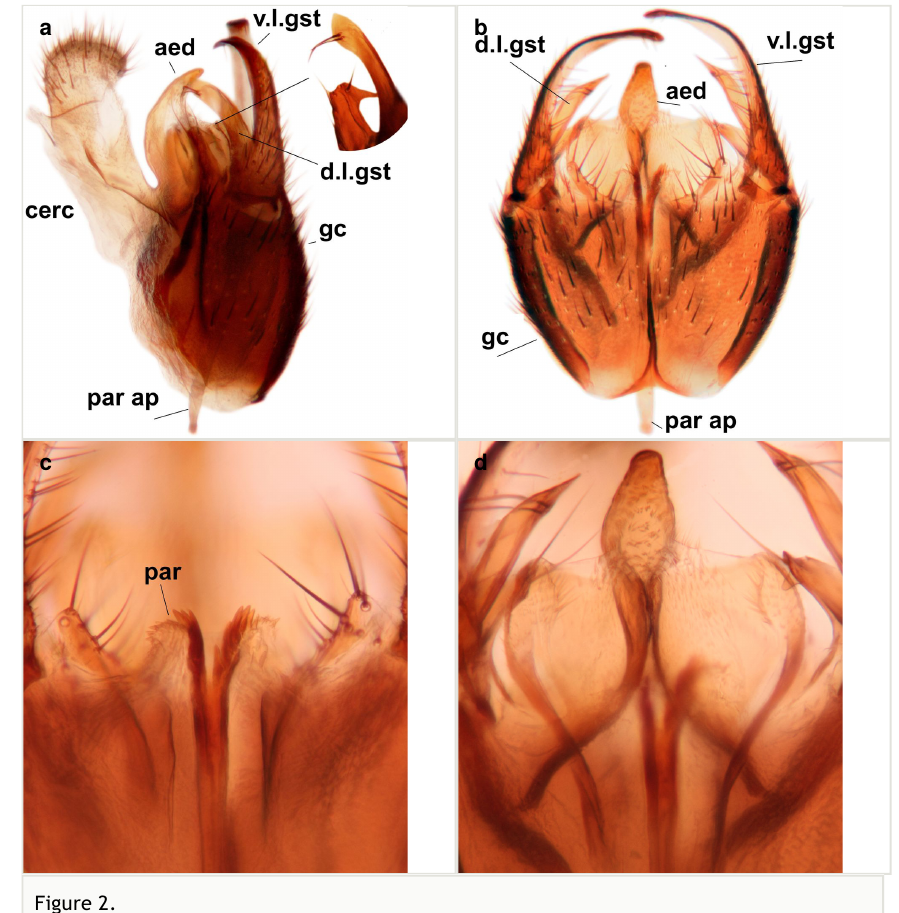
Figure 2. Orfelia boreoalpina Salmela sp.n., holotype male, hypopygium. a : Hypopygium, lateral view. cerc=cerci, aed, aedeagus, gst=gonostylus, v.l.gst=ventral lobe of gst, d.l.gst=dorsal lobe of gst, gc=gonocoxite, par ap=parameral apodeme. Dorsal outgrowth of the gonocoxites is shown in the